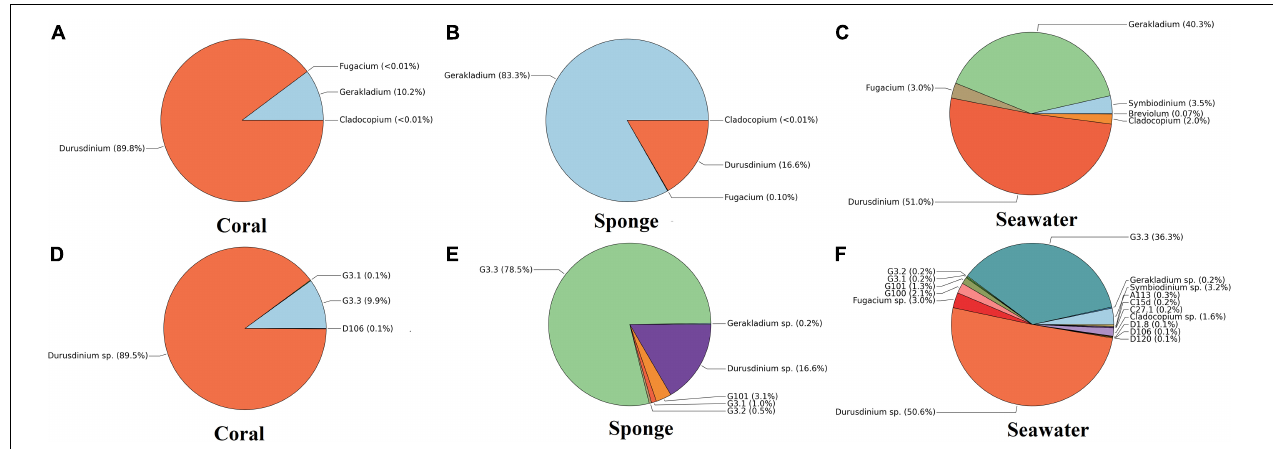
FIGURE 4 | Symbiodiniaceae community composition at Grande Island. (A–C) Relative abundances of Symbiodiniaceae genera in host (coral and sponge) and free living in seawater. (D–F) Relative abundances of Symbiodiniaceae at subtypes level in host (coral and sponge) and free living in seawater. Values represent mean relative abundances across group